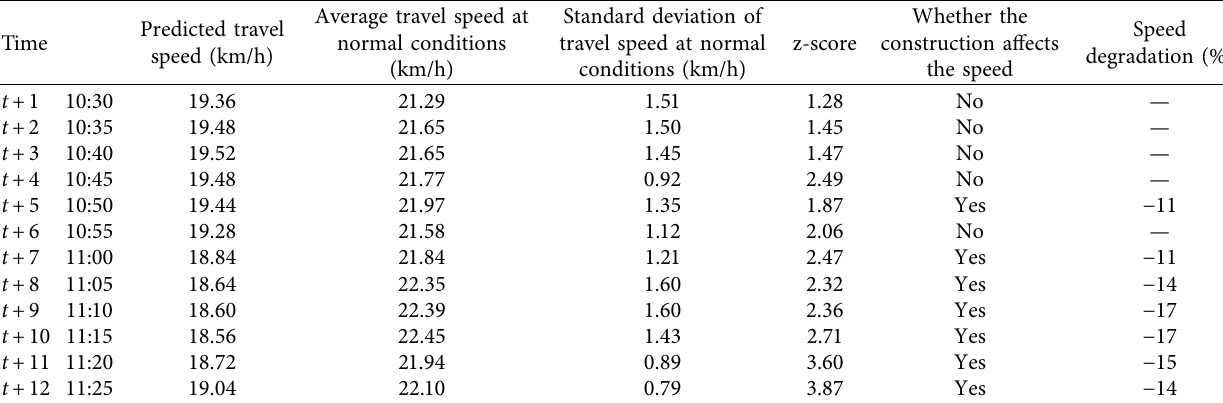
Table 6: Impact analysis result of road work based on actual